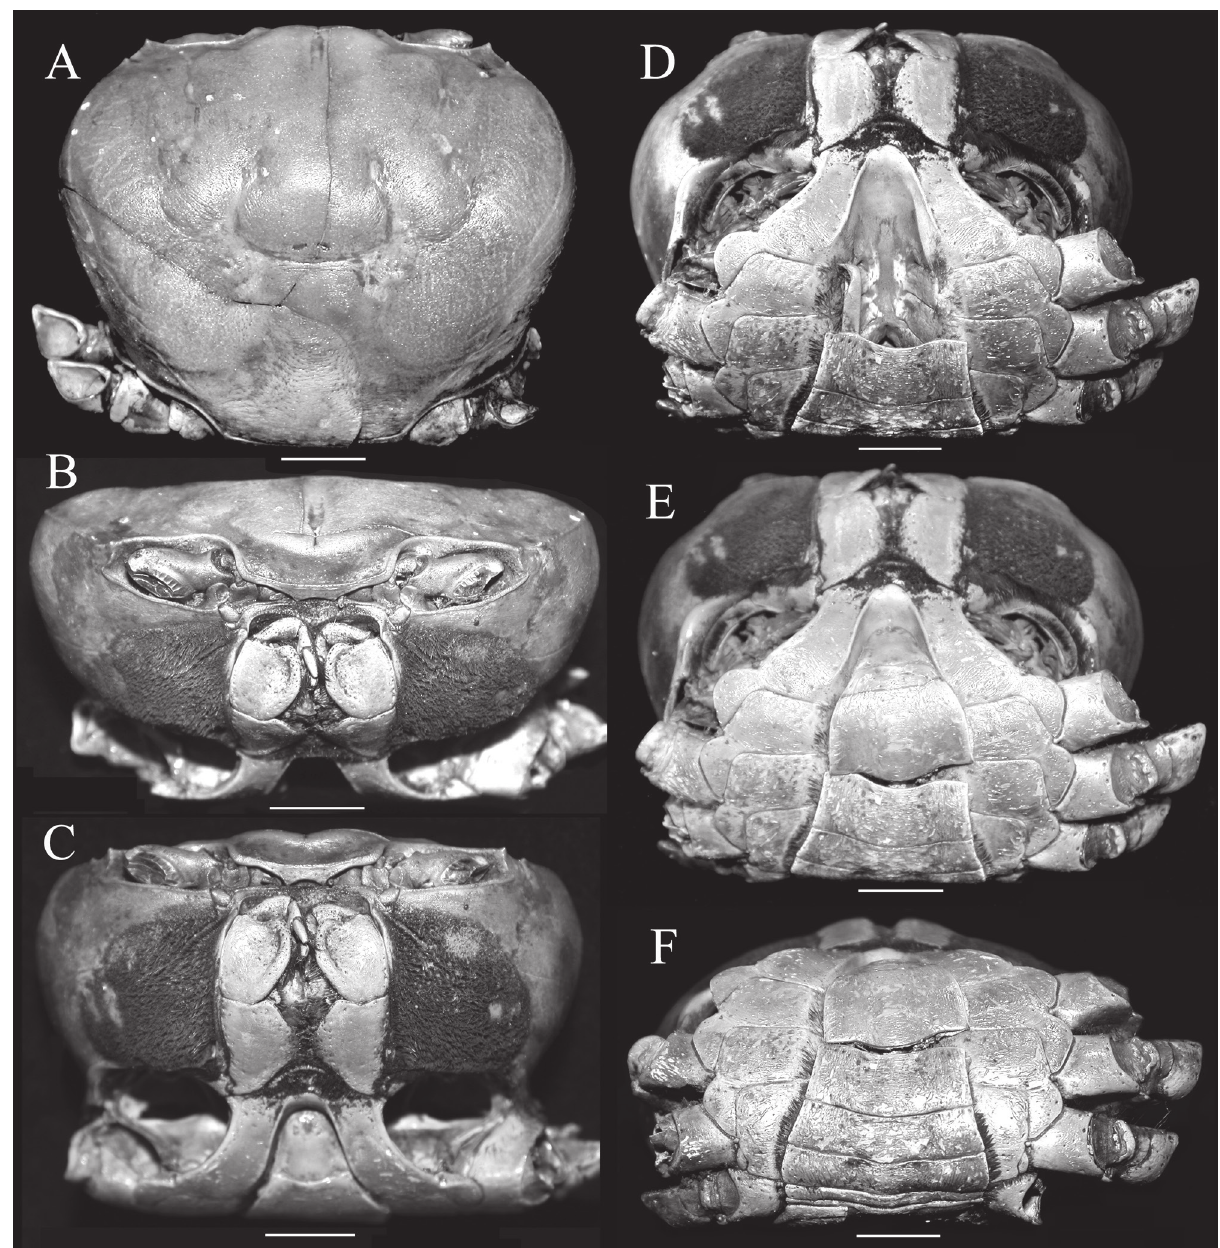
Figure 2. Cardisoma hirtipes Dana, 1851, lectotype male (58.2 × 47.4 mm) (USNM 2356). A, dorsal view of carapace; B, C, frontal view of cephalothorax; D–F, ventral view of of cephalothorax showing thoracic sternum and abdomen. Scale bars = 10.0